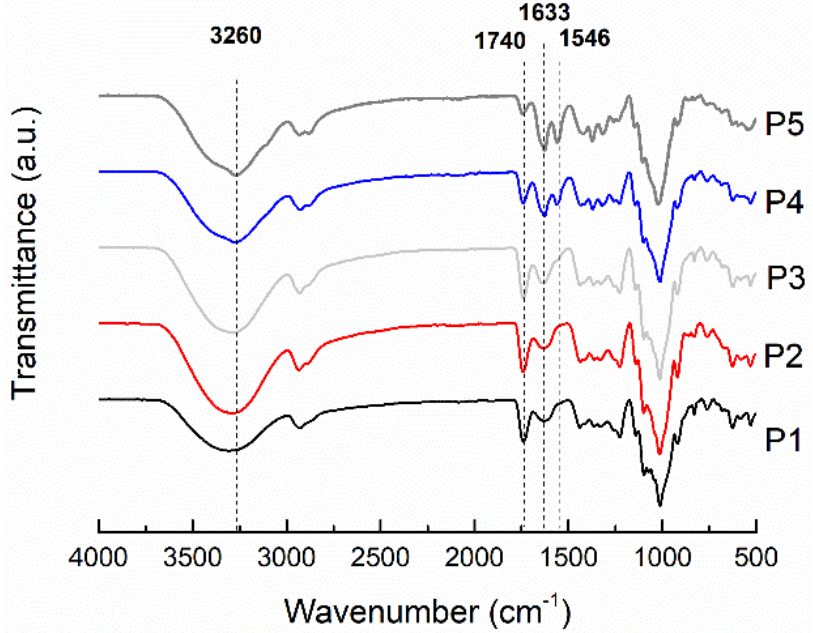
Figure 3. FTIR/ATR spectra of control pectin film and pectin-based biocomposite film.